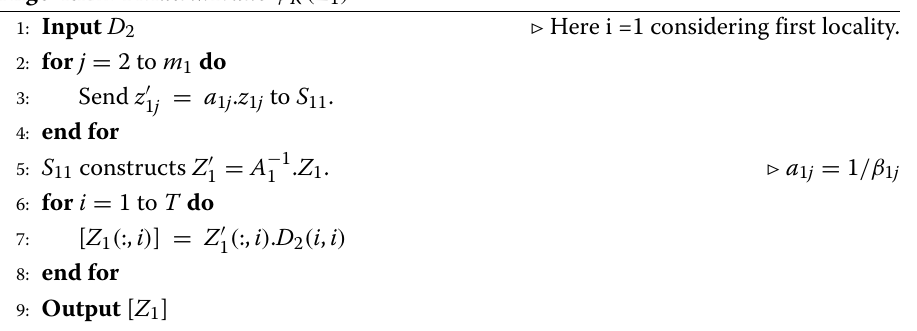
Algorithm 4 MatrixTrans ψ K ( Z 1 )